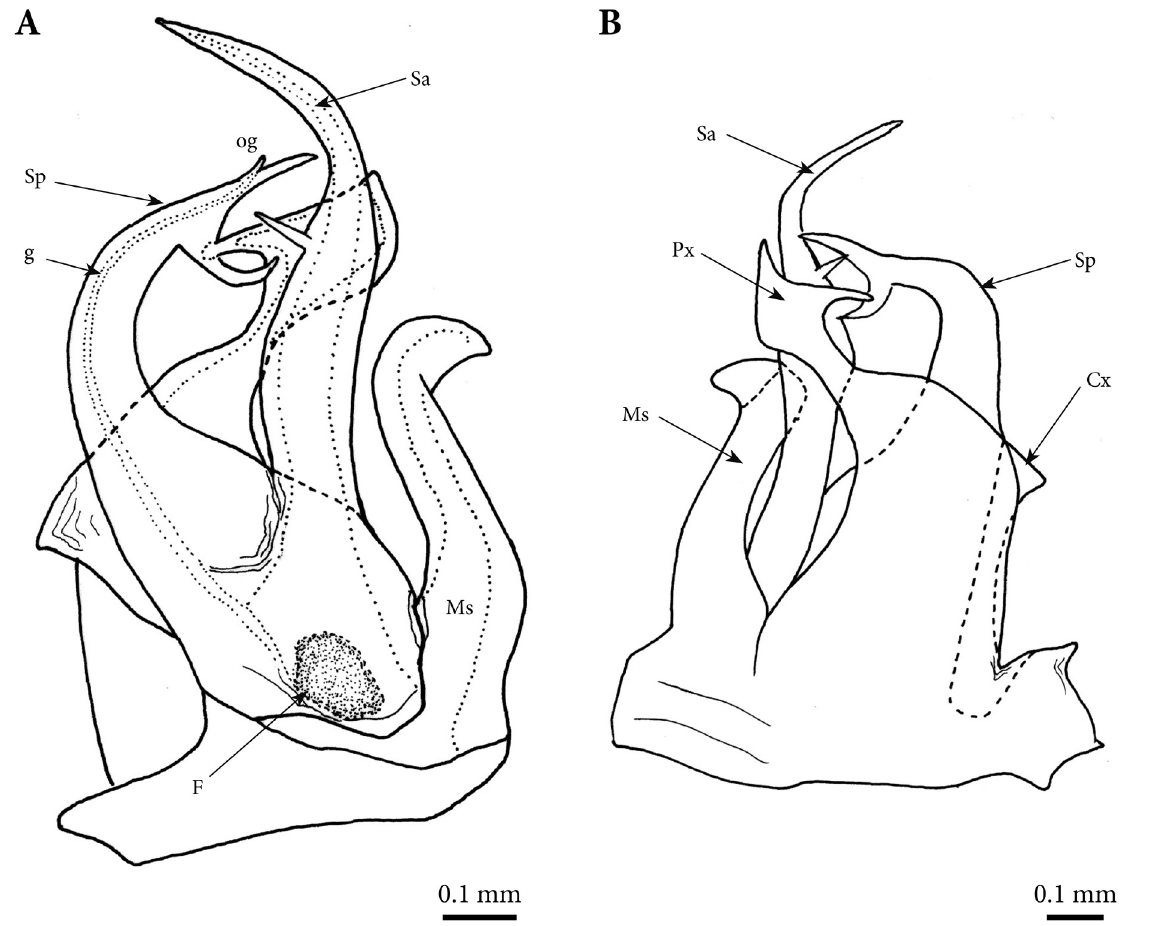
Fig. 21. Ommatoiulus staglae sp. nov. Holotype ♂, right posterior gonopod. A . Mesal view. B . Lateral